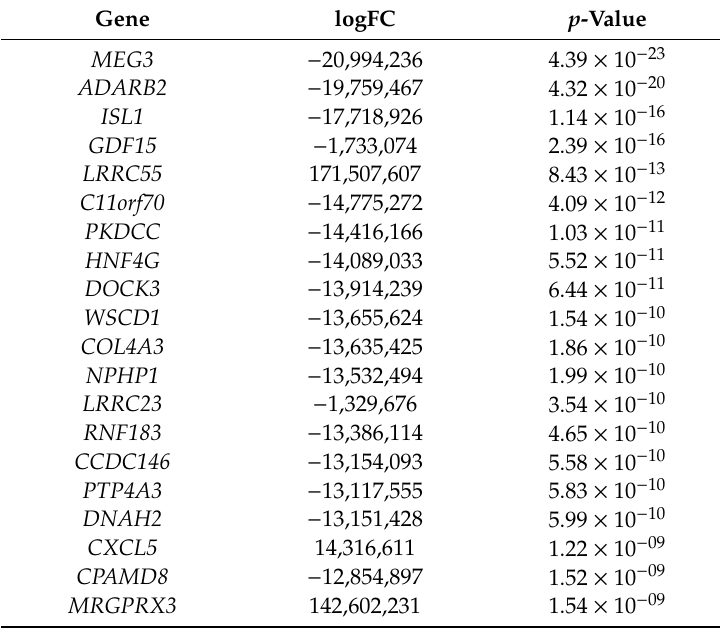
Table 4. 20 most relevant DEGs exclusively in lip tumour samples compared with normal